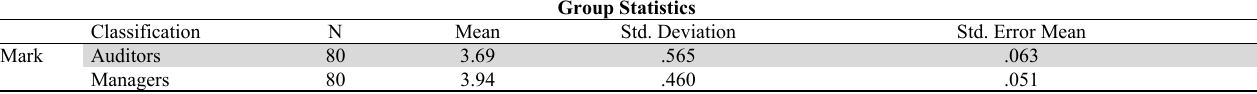
Evaluation of the impact of legal document guidelines on the application of the international financial reporting standards for SMEs from the perspective of auditors and